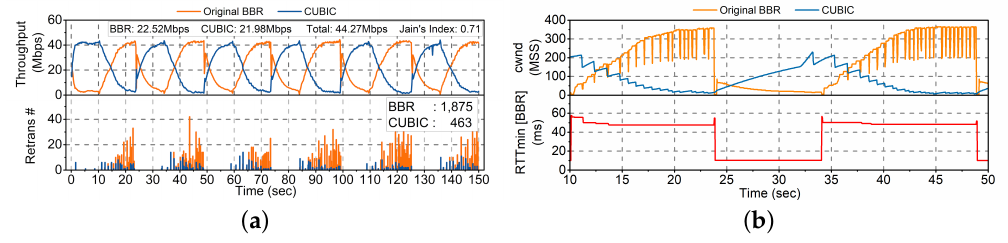
Figure 10. Original BBR vs. CUBIC (deep buffer: 5 BDP): ( a ) throughput and retransmission; and ( b ) cwnd and RTprop of the original BBR.